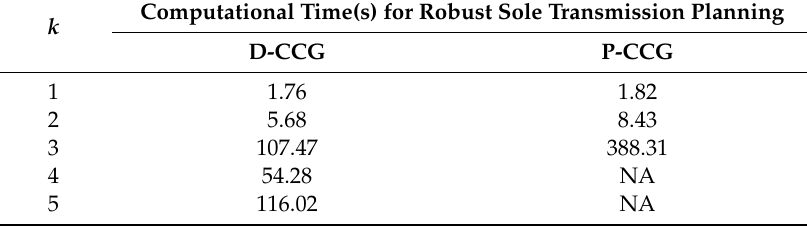
Table 5. Computation time of D-CCG and P-CCG for the IEEE 30-bus power system under di ff erent k ’s. Computational Time(s) for Robust Sole Transmission Planning k D-CCG